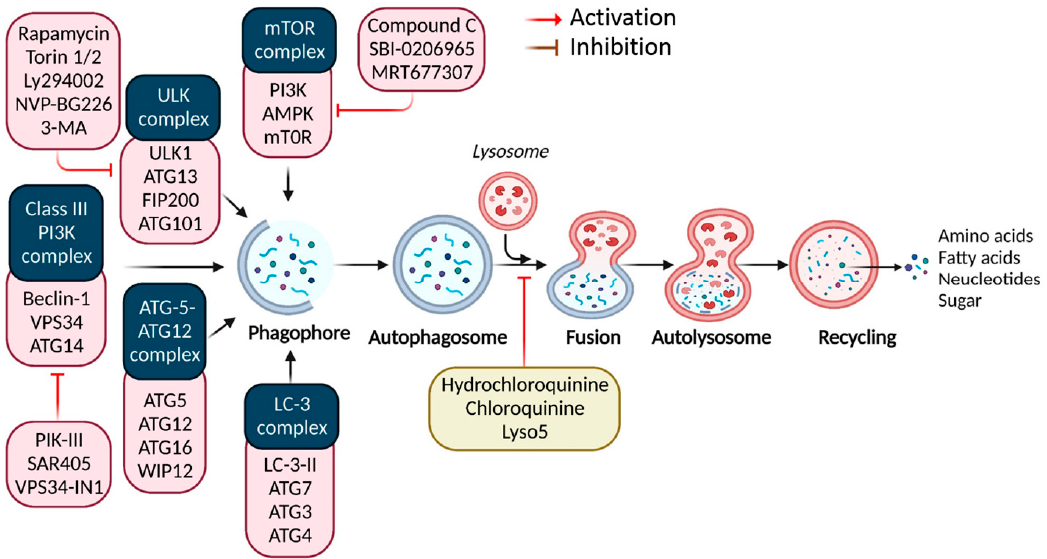
Figure 5. Cellular targets of medications targeting autophagy in cancer in preclinical and clinical settings. Clinical investigations involving autophagy suppression.